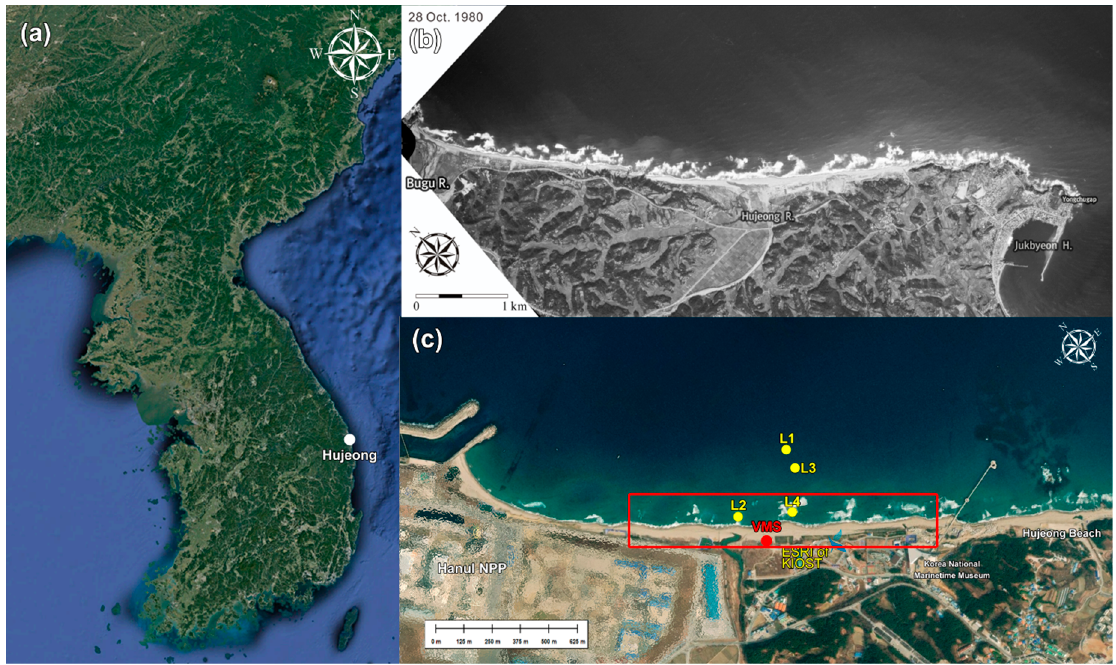
Figure 1. ( a ) Google map of Korean peninsula with location of Hujeong Beach, ( b ) aerial photo over Hujeong Beach in 1980 when the beach was in equilibrium before construction of Hanul Nuclear Power Plant (NPP), ( c ) locations of deployed instruments (L1 & L2 for Exp#1, L3 & L4 for Exp#2) on google map of Hujeong Beach. The red dot marks the location where the VMS was installed, and the red rectangle marks the coverage of the VMS. The map also shows that crescentic sandbars are actively developed in the nearshore areas of the beach.